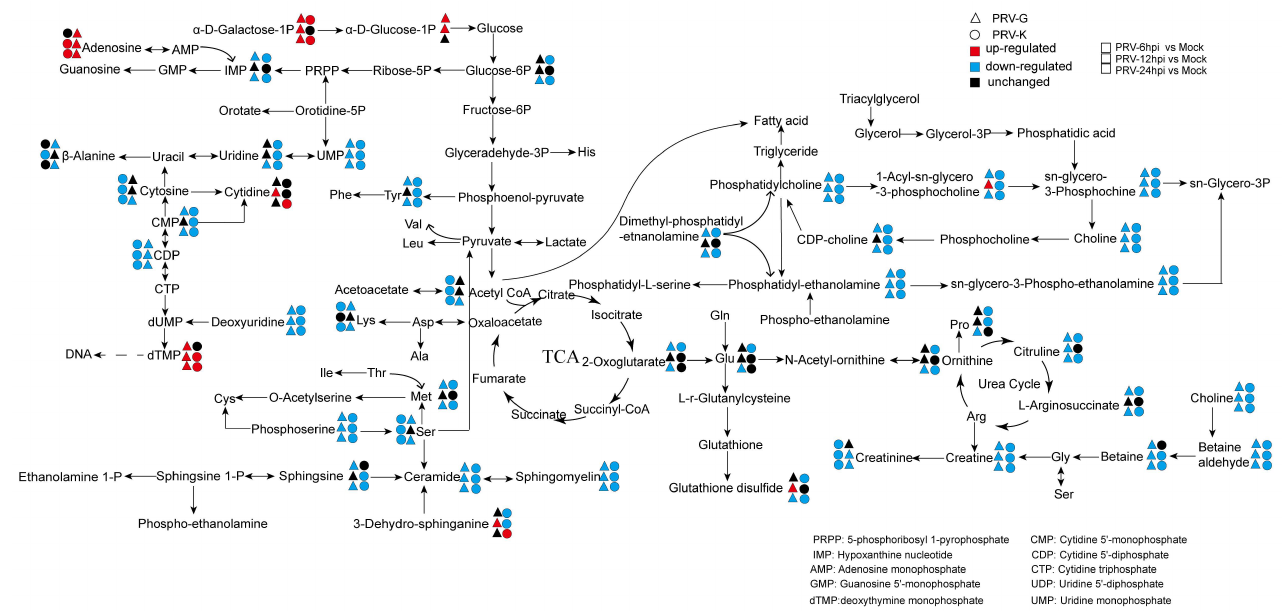
Figure 6. Schematic overview of altered metabolic pathways in PK-15 cells infected with different PRV strains. The metabolites were shown in different colors according to their changes. Black: unchanged; red: upregulated; blue: